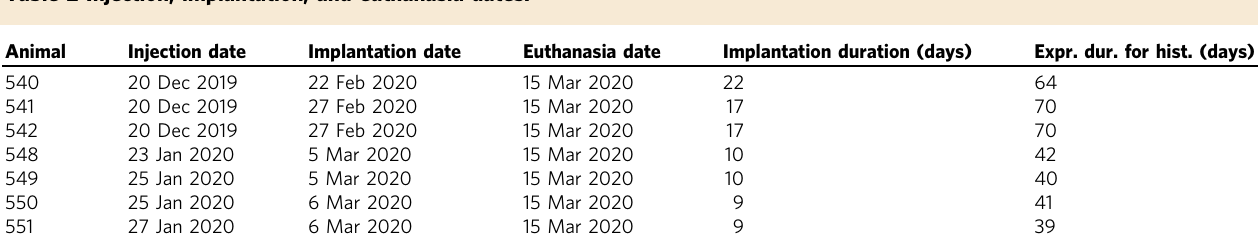
Table 2 Injection, implantation, and euthanasia